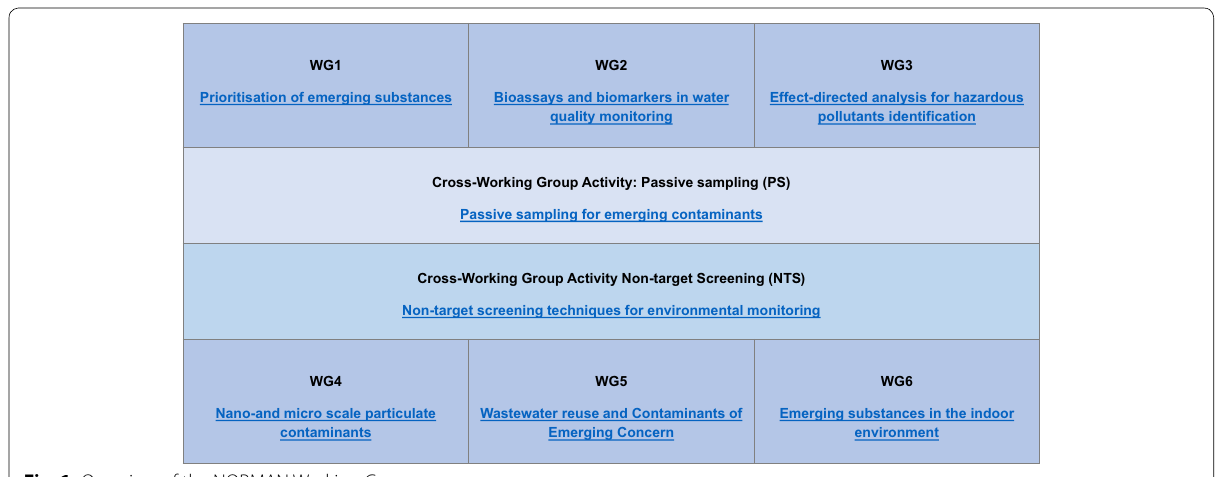
Fig. 1 Overview of the NORMAN Working